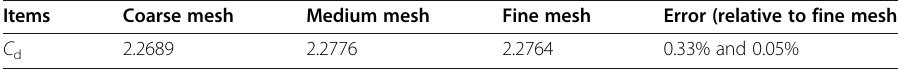
Table 4 Drag coefficients (C d ) for different meshes